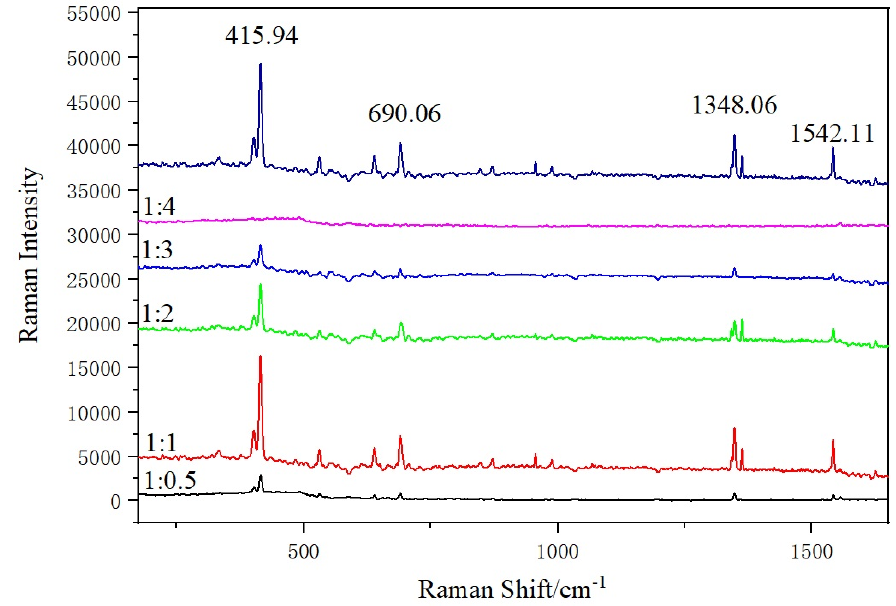
Figure 8. SERS spectra of different volume ratios of Fe 3 O 4 @PDA@Au@GO substrate and phenanthrene solution.